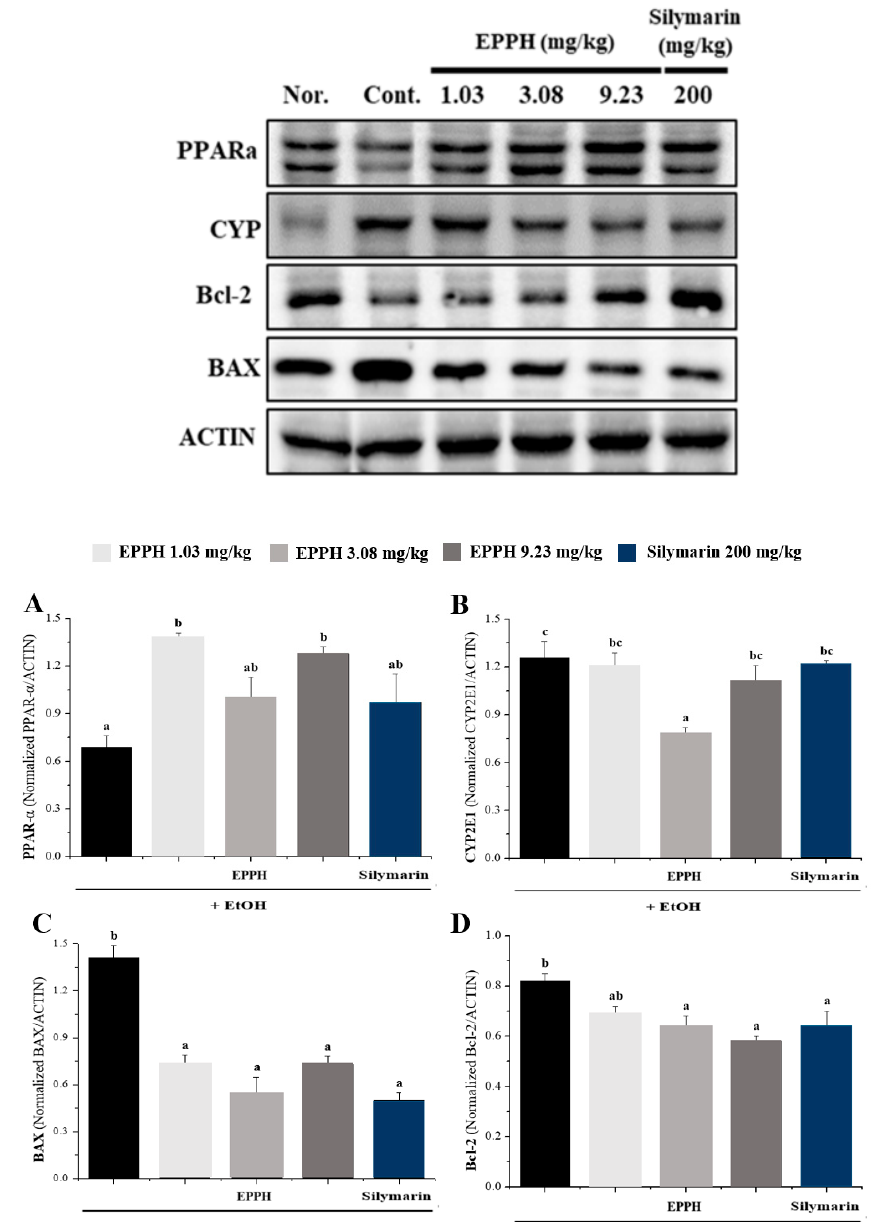
Figure 5. Effects of EPPH on protein expression of PPAR α , CYP 2E1, Bcl-2, and BAX in mouse livers, Adult male C57BL/6 mice were administered EtOH without or with EPPH for 42 days, then mouse livers were collected. Protein from mouse livers was analyzed by Western blots for the protein expression of each PPAR α , CYP 2E1, Bcl-2, and BAX were analyzed by Western blotting. Silymarin is a positive control. For quantitative comparison of Western blots for each ( A ) PPAR α , ( B ) CYP2E1, ( C ) BAX and ( D ) Bcl-2, it was separated and quantified by ACTIN and expressed as a comparative graph. The data are expressed as the mean ± SD ( n = 10), and different letters indicate (c > b > a) a significant difference at p < 0.05, as determined by Duncan’s multiple-range